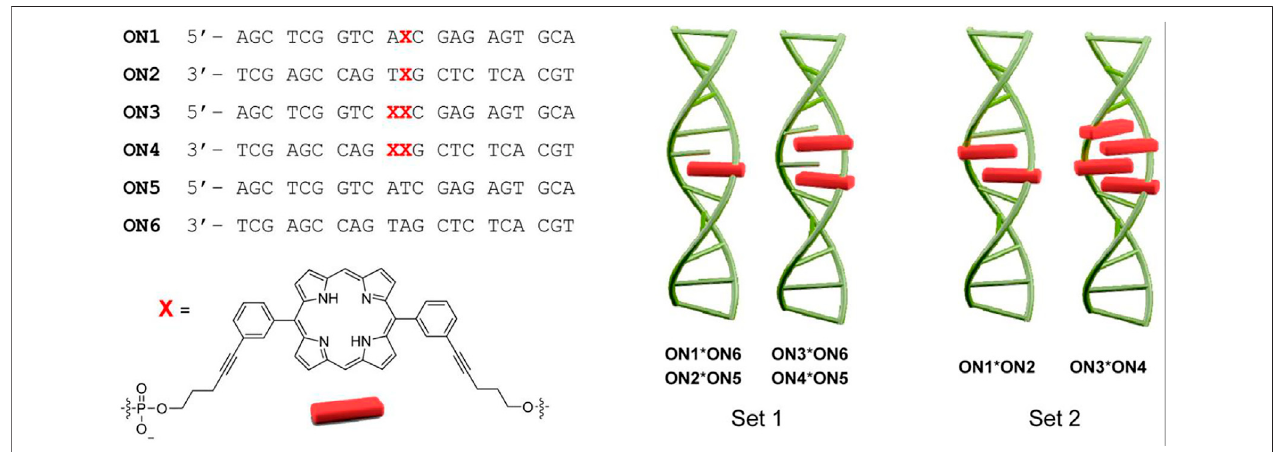
FIGURE 3 | ON sequences modi fi ed with different numbers of the porphyrins (denoted by X) using phosphoramidite chemistry. The hybridization of the ONs enables the formation of various duplexes differing in the number of stacked porphyrins. Adapted with permission from (Vybornyi et al., 2014).